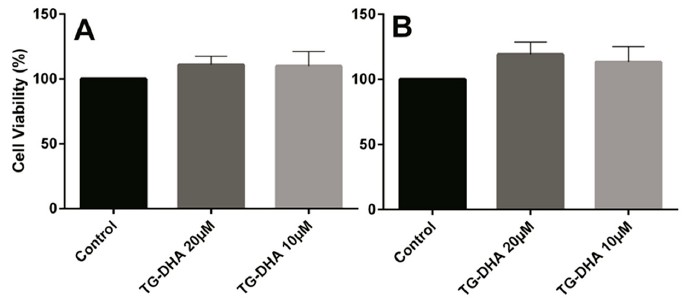
Figure 3. Effects of DHA in splenocyte and CD4+ T cells viability. Splenocytes ( A ) and CD4+ T cells